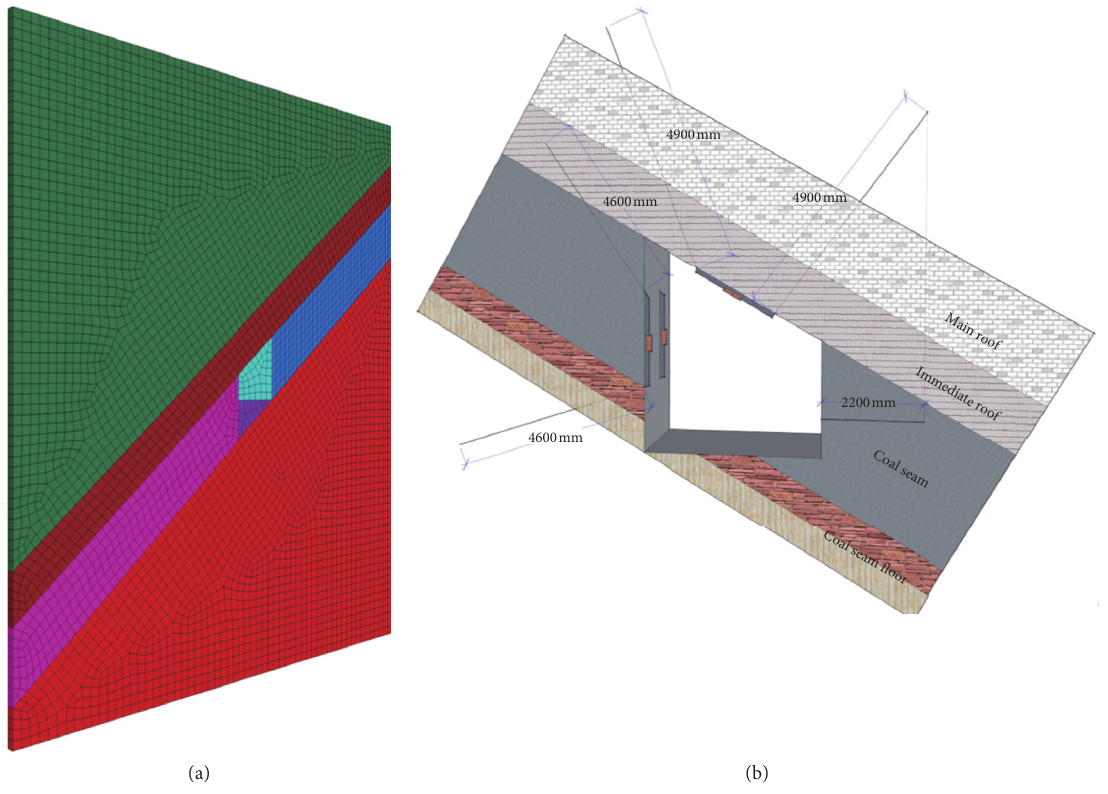
Figure 5: FLAC3D numerical modeling of the roadway and schematic diagram of roof-side anchor cable truss.